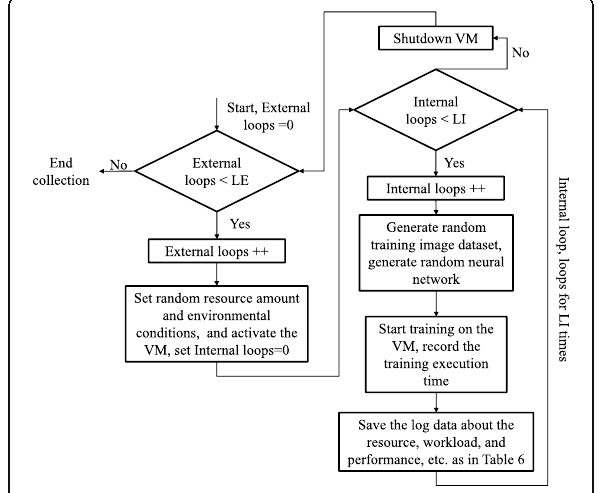
Fig. 6 Workflow to collect log data in the